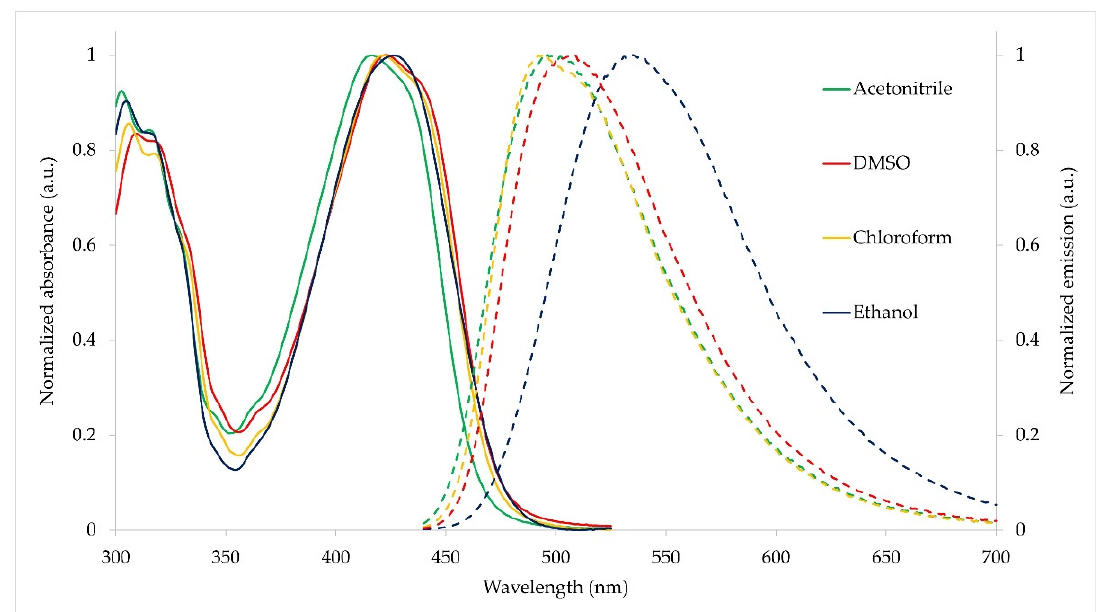
Figure 1. The UV-Vis absorption and fluorescence emission spectra of 3-(phenylethynyl)-7 H -benzo[ de ]anthracen-7-one in various organic solvents.